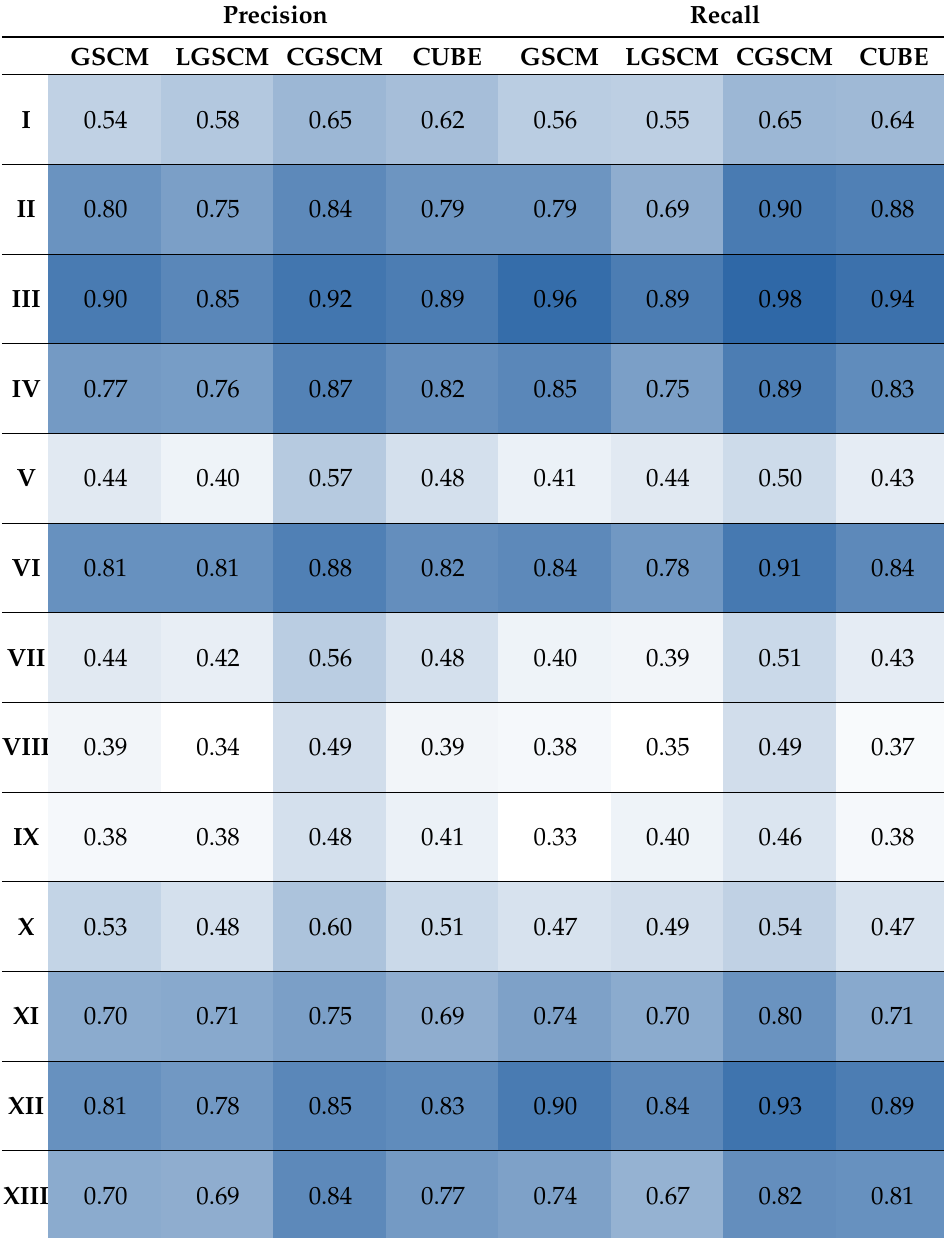
Table 4. Recall and Precision for each encoding in Experiment one. The blue color value indicates the magnitude of the